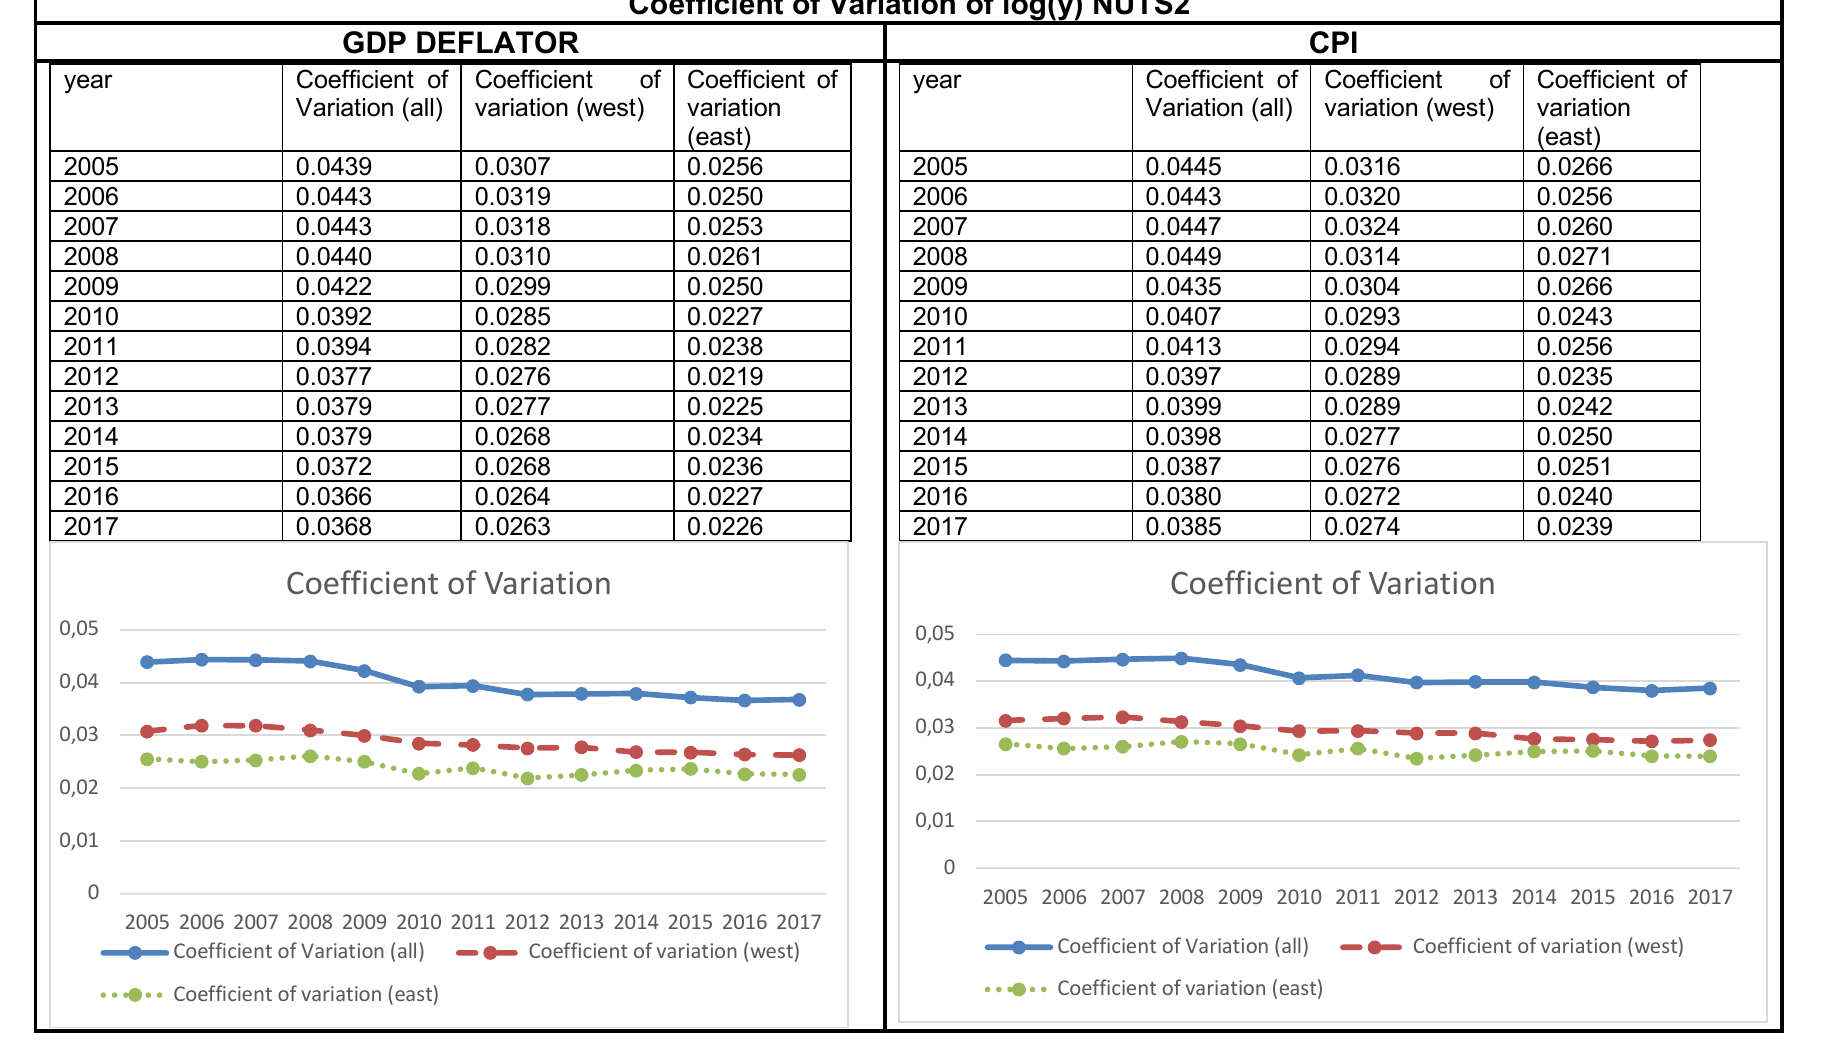
Table A.4 : Comparison between GDP Deflator and CPI (2005-2017) (4) Coefficient of Variation of log(y) NUTS2 GDP DEFLATOR